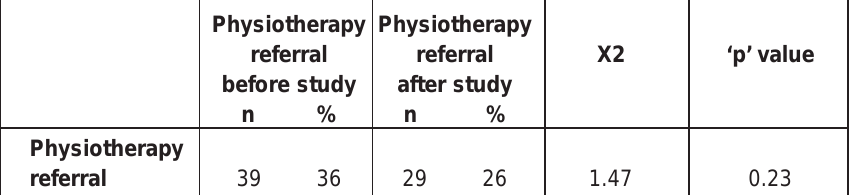
Table 2: Physiotherapy referral to the factory’s clinic 12 months before and after the administration of Back School.